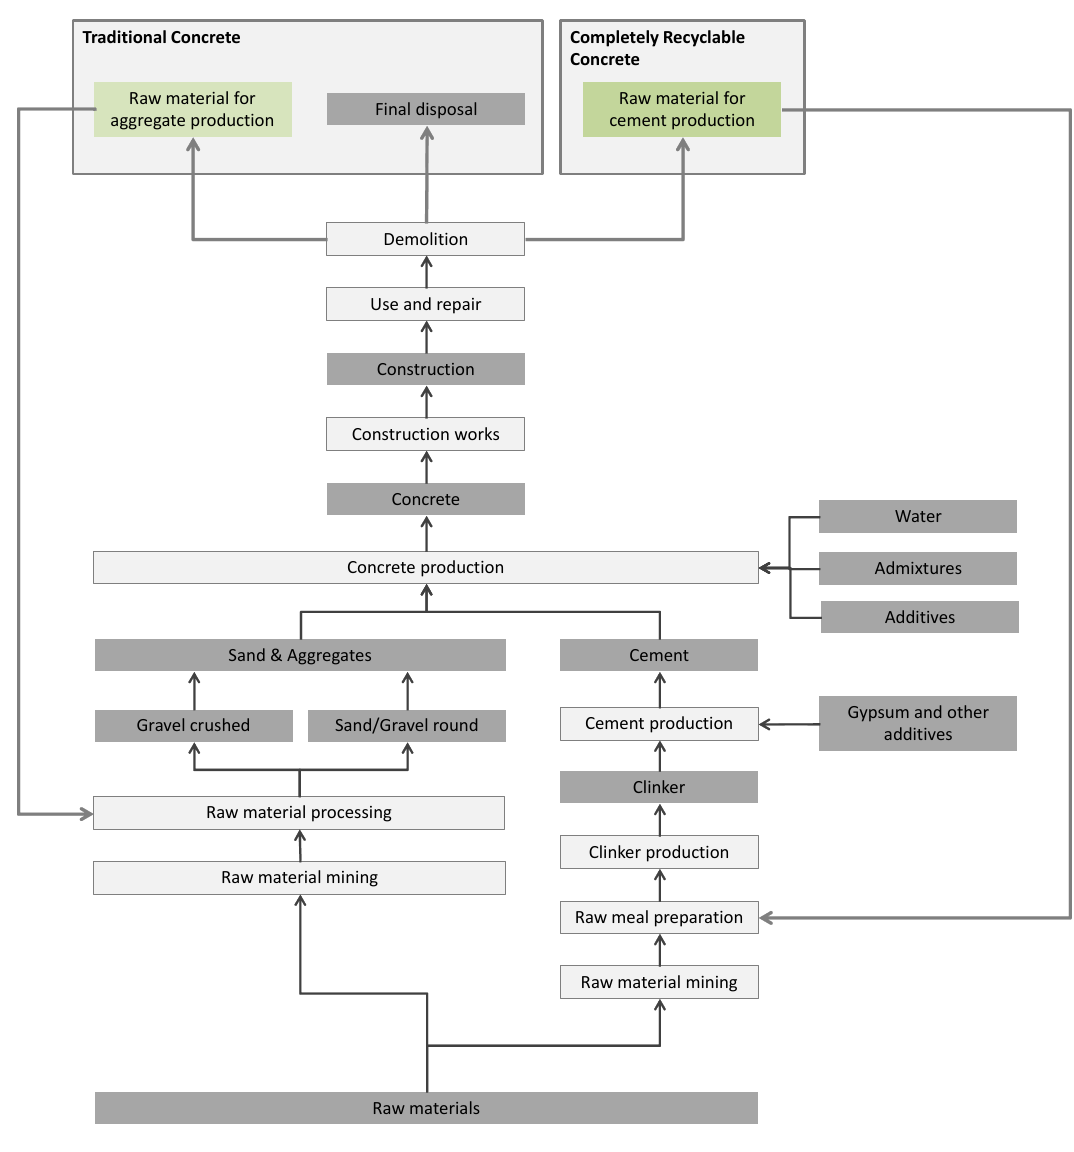
Figure 1. Life cycle of